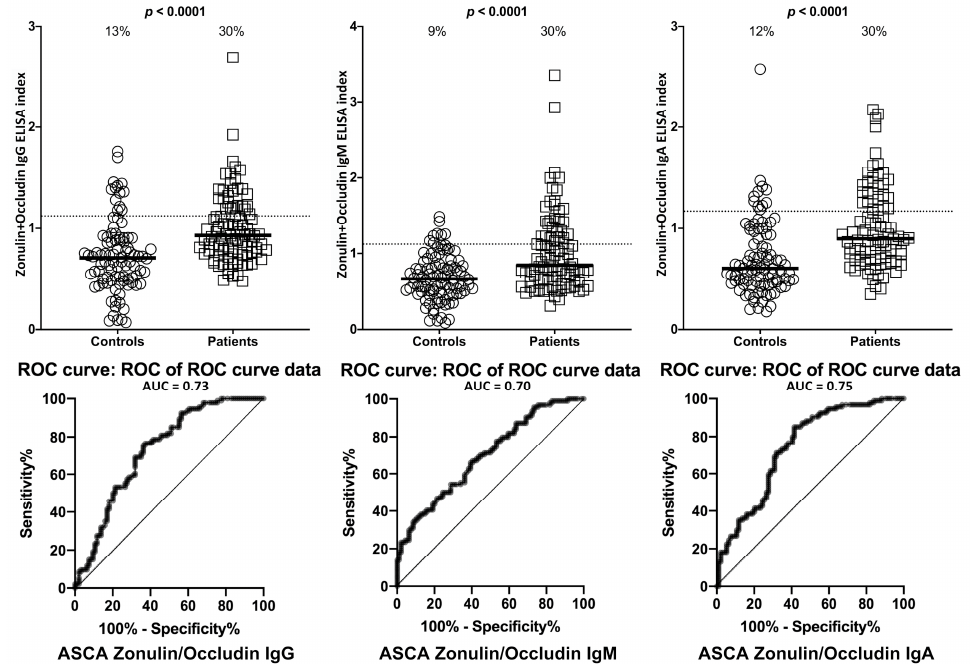
Figure 2. Percentage of elevation of IgG, IgM, and IgA antibodies against zonulin+occludin in 94 patients positive for ASCA and in 94 healthy controls. Dotted lines indicate the cutoff for positivity used in each assay, as calculated by ROC analysis. The percentage of elevation is indicated on top of each distribution, while bars indicate the corresponding median. The AUC for zonulin+occludin IgG was 0.73, 0.70 for zonulin+occludin IgM, and 0.74 for zonulin+occludin IgA. Int. J. Mol. Sci. 2020 , 21 , x FOR PEER REVIEW Using the same criteria for the calculation of % of antibody elevation, while 29% (27/94) to 31% (29/94) of ASCA-positive samples showed significant elevations in these antibodies, 5% (5/94), 12% (11/94), and 2% (2/94) of controls had elevations in IgG, IgM, and IgA antibodies against S100B, with p -values < 0.0001 for all three determinations (Figure 3).